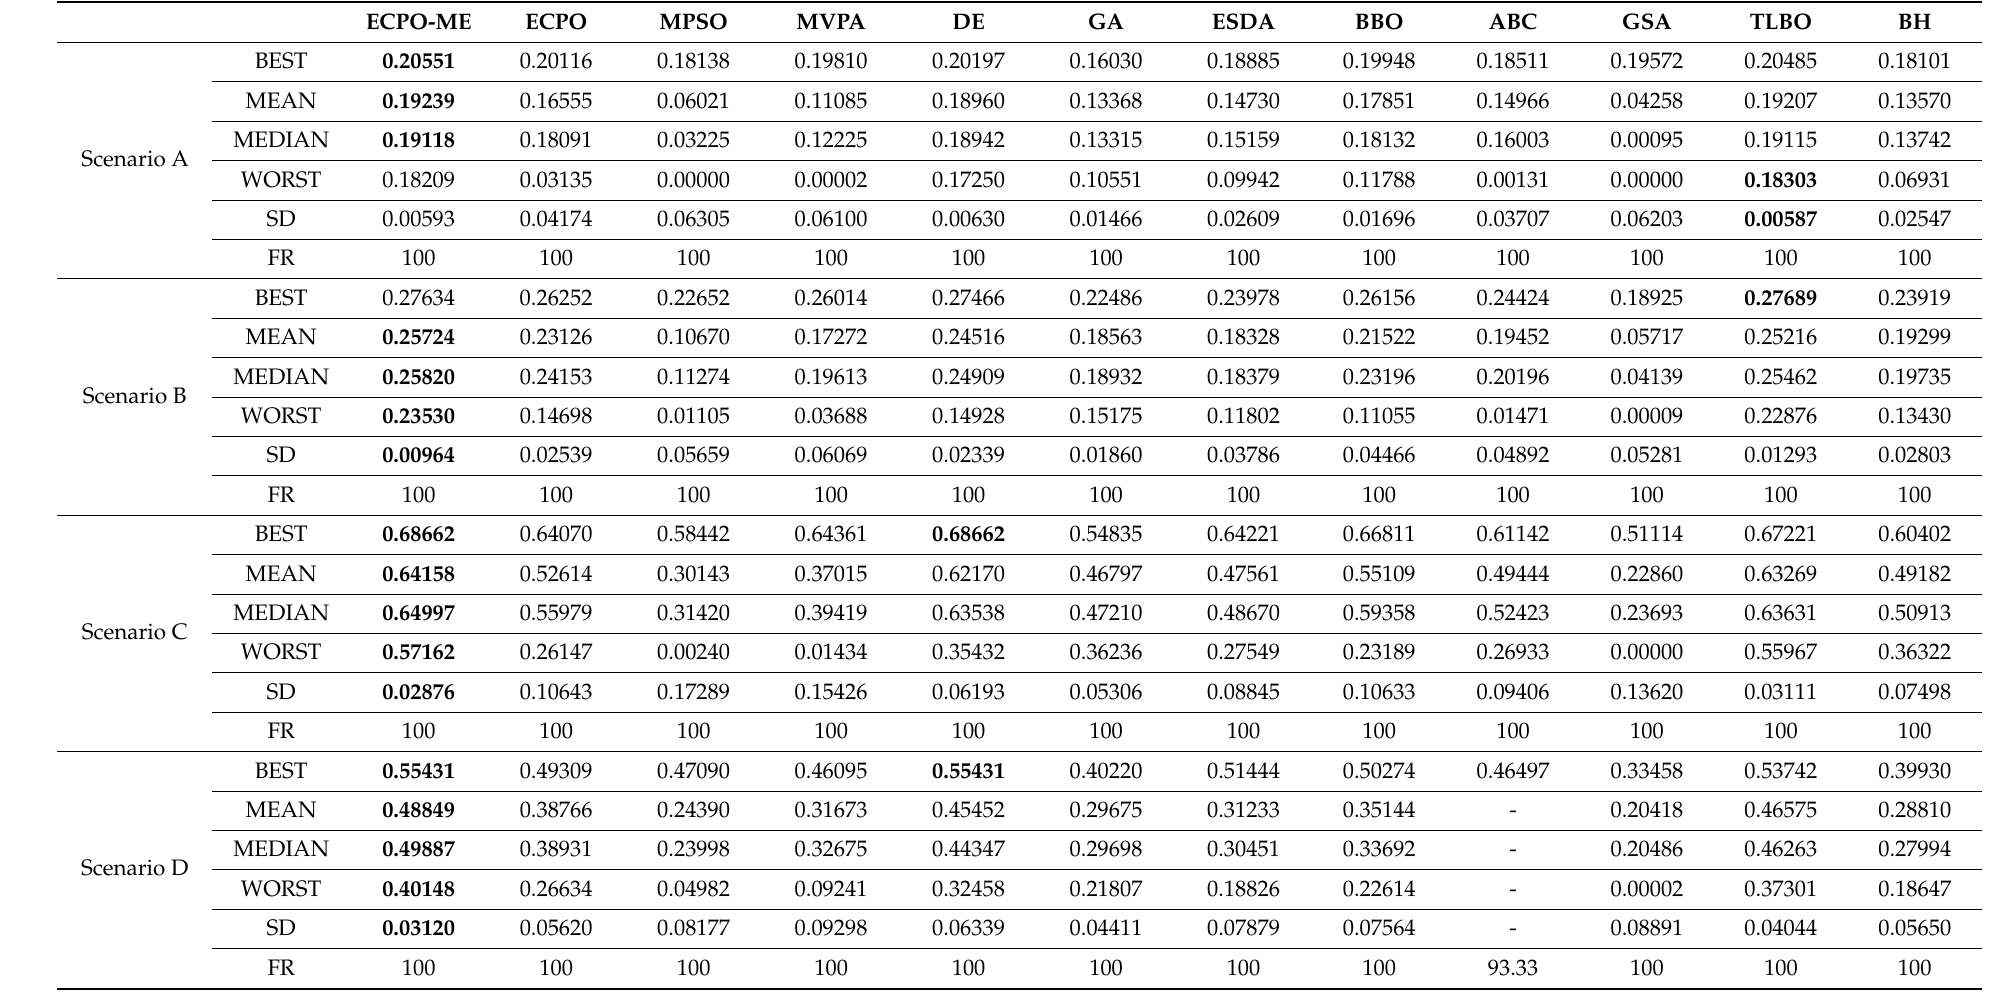
Table 1. Statistical analysis of the obtained results using each algorithm. The bold in table shows the best